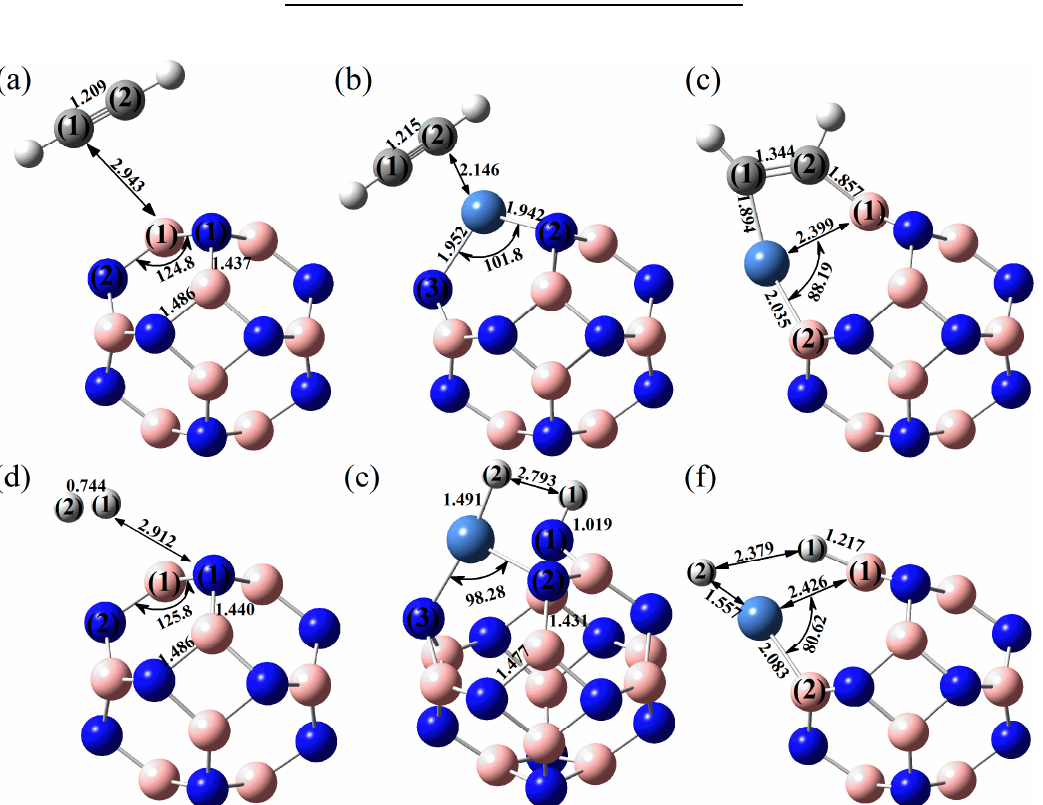
Figure 4. The optimised structures of C 2 H 2 absorbed on B 12 N 12 ( a ), B 11 N 12 Ni ( b ) and B 12 N 11 Ni ( c ); the optimised structures of H 2 absorbed on B 12 N 12 ( d ), B 11 N 12 Ni ( e ) and B 12 N 11 Ni ( f ). H atom is white; B atom is pink; C atom is grey; N atom is mazarine; Ni atom is blue.